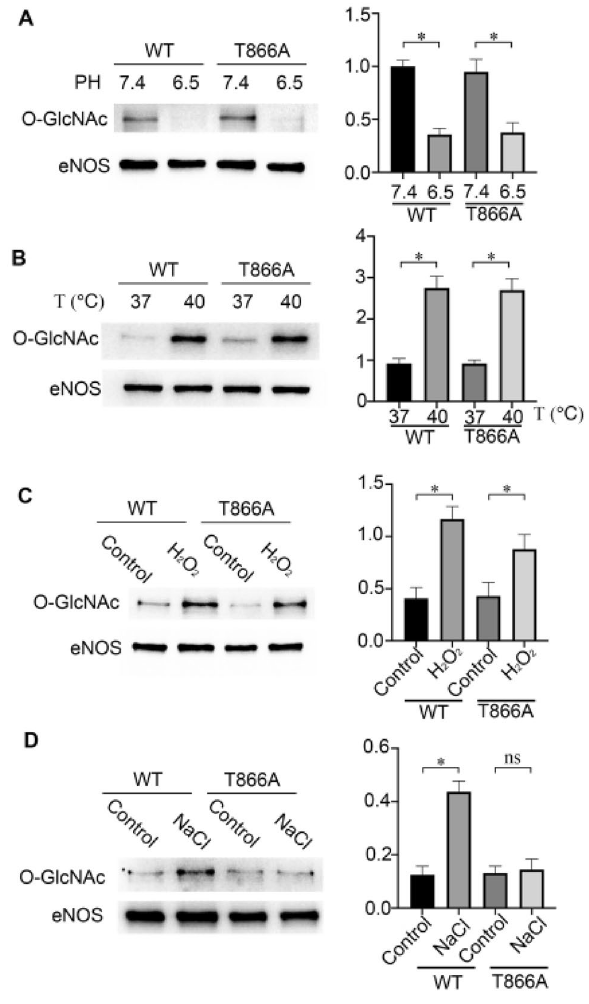
Figure 2. Changes in the levels of O-GlcNAc/eNOS in HEK293 cells ( A ) After decreasing PH, changes in the expression of O-GlcNAc/eNOS in HEK293 cells. Typical images and statistical graphs are shown, n = 3. ( B ) Changes in the levels of O-GlcNAc/eNOS in HEK293 cells under hyperthermic conditions. Typical images and statistical graphs are shown, n = 3. ( C ) Changes in the levels of O-GlcNAc/eNOS in HEK293 cells treated with hydrogen peroxide. Typical images and statistical graphs are shown, n = 3. ( D ) Changes in the levels of O-GlcNAc/eNOS in HEK293 cells treated with NaCl (200 mM). Typical images and statistical graphs are shown, Full-length blots are presented in Supplementary Figure S7A, S8B, S9C, S10D. n = 3. *P < 0.05; ns indicates no